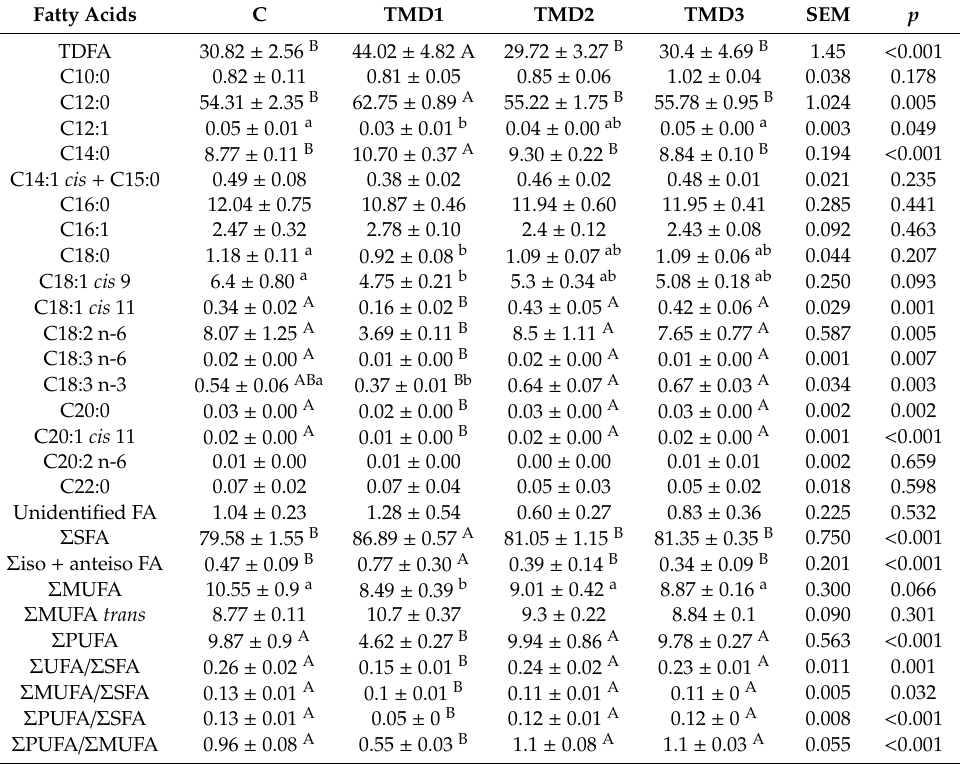
Table 7. Total detected fatty acid (TDFA) content (mg / 100 g DM) and main fatty acid content (g / 100 g of TDFA) of black soldier fly prepupae (BSFPs) reared on the control (C) or the experimental diets